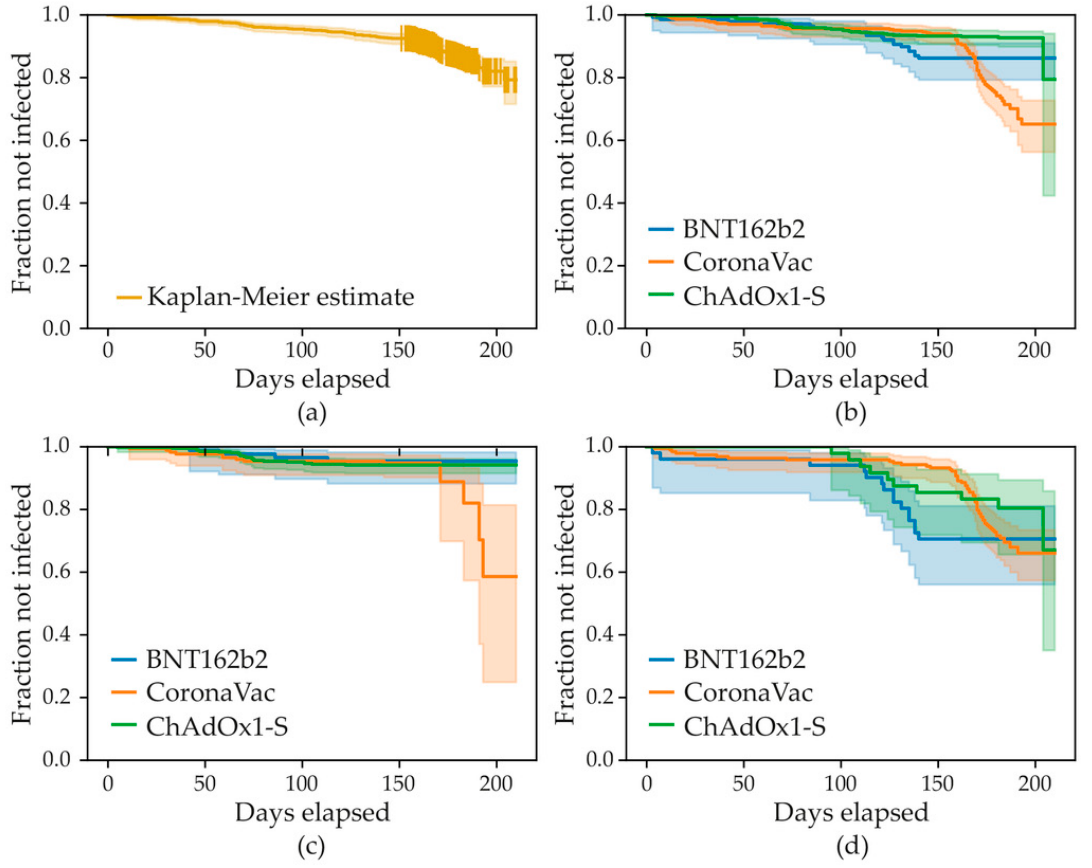
Figure 2. Survival analysis curves over 210 days follow-up on the x axis. ( a ) Kaplan–Meier estimate for the whole population. ( b ) Kaplan–Meier estimates stratified by vaccine type: BNT162b2, ChAdOx1-S, and CoronaVac. ( c ) Kaplan–Meier estimates stratified by vaccine and date: before 15 December 2021 for BNT162b2, ChAdOx1-S, and CoronaVac vaccines. ( d ) Kaplan–Meier estimates stratified by vaccine and date: after 15 December 2021 for BNT162b2, ChAdOx1-S, and CoronaVac vaccines.